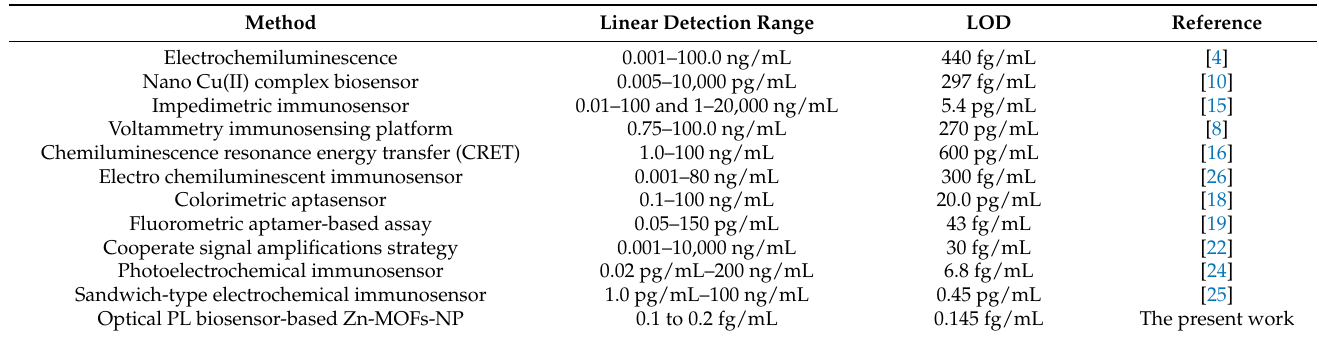
Table 2. The Zn-MOFs-NP biosensor in comparison to some existing methods for the determination of